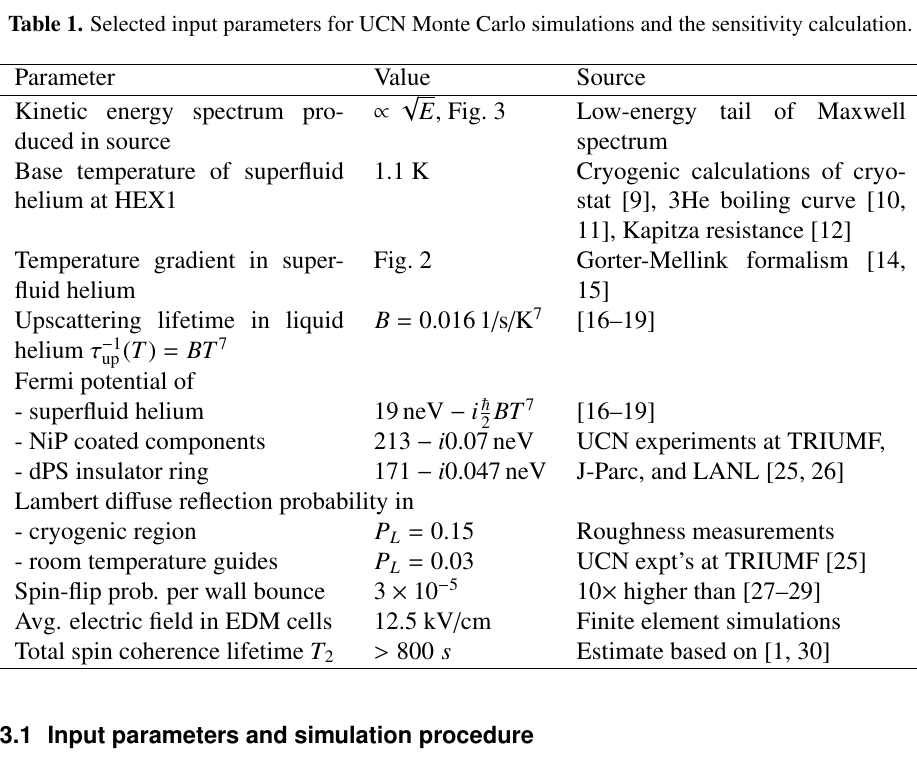
Table 1. Selected input parameters for UCN Monte Carlo simulations and the sensitivity calculation.